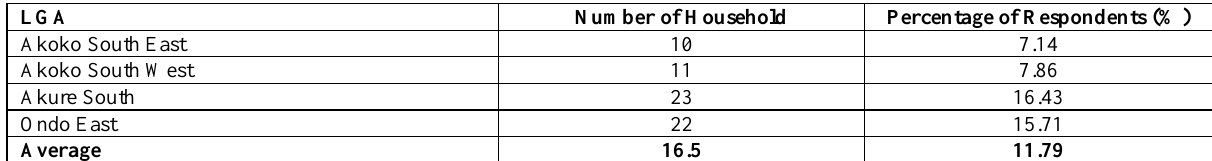
Table 3. Distribution of Households with Pre-Paid Meters by LGA